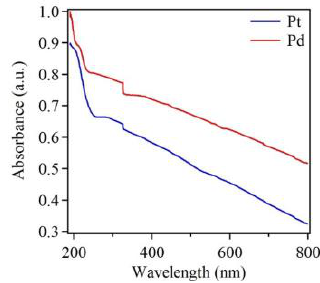
Figure 6. Normalized UV-Vis spectra of Pt and Pd nanostructures deposited on Si substrates after five deposition cycles, showing characteristic peaks and increasing absorption toward shorter wavelengths. The spectrum of Pt nanostructures is shifted downward for clarity.